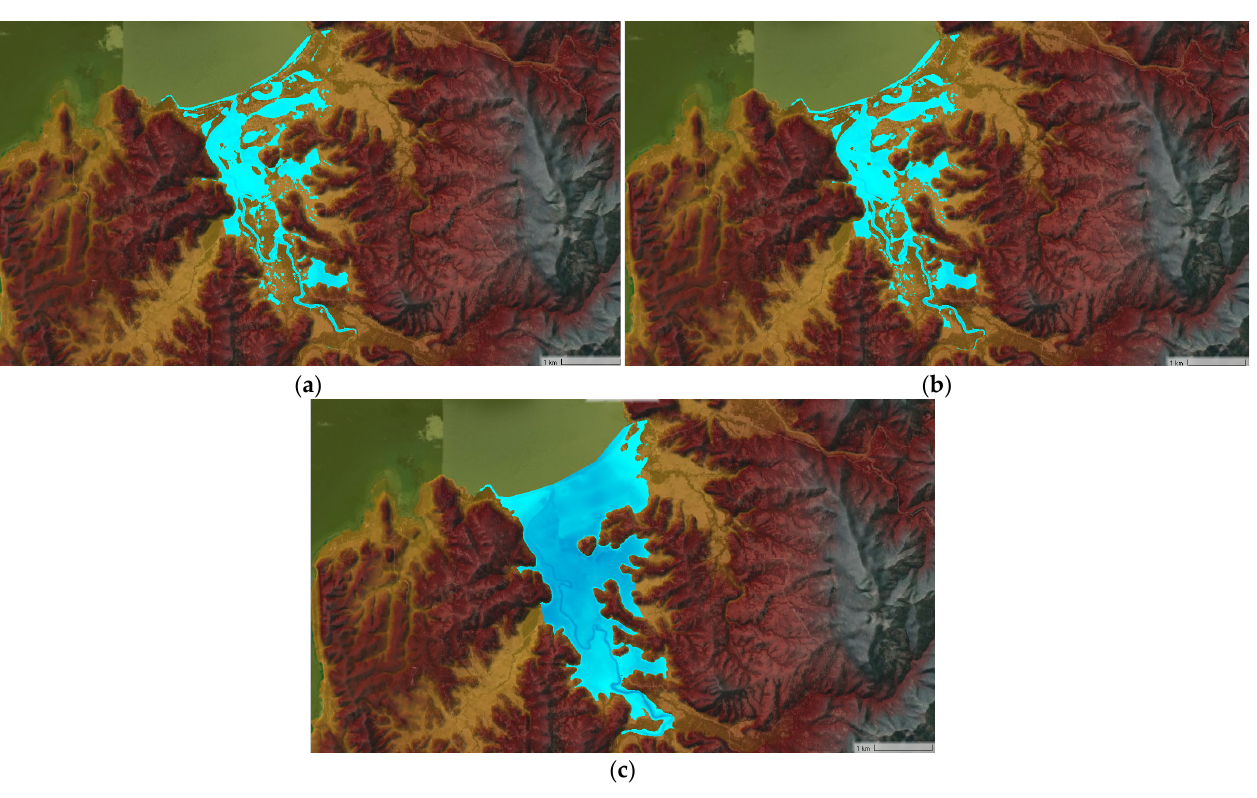
Figure 5. Simulation of total inflow results in 100 ‐ year using HEC ‐ HMS.